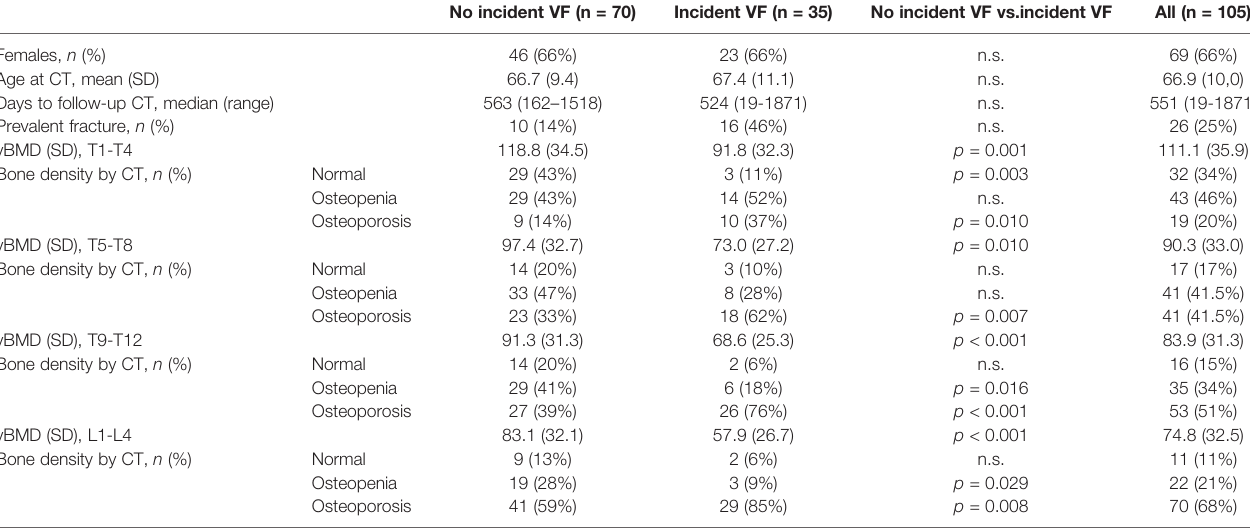
TABLE 2 | Baseline characteristics of patients with and without incident vertebral fracture (VF). No incident VF (n = 70) Incident VF (n = 35) No incident VF vs.incident VF All (n = 105) Females, n (%)